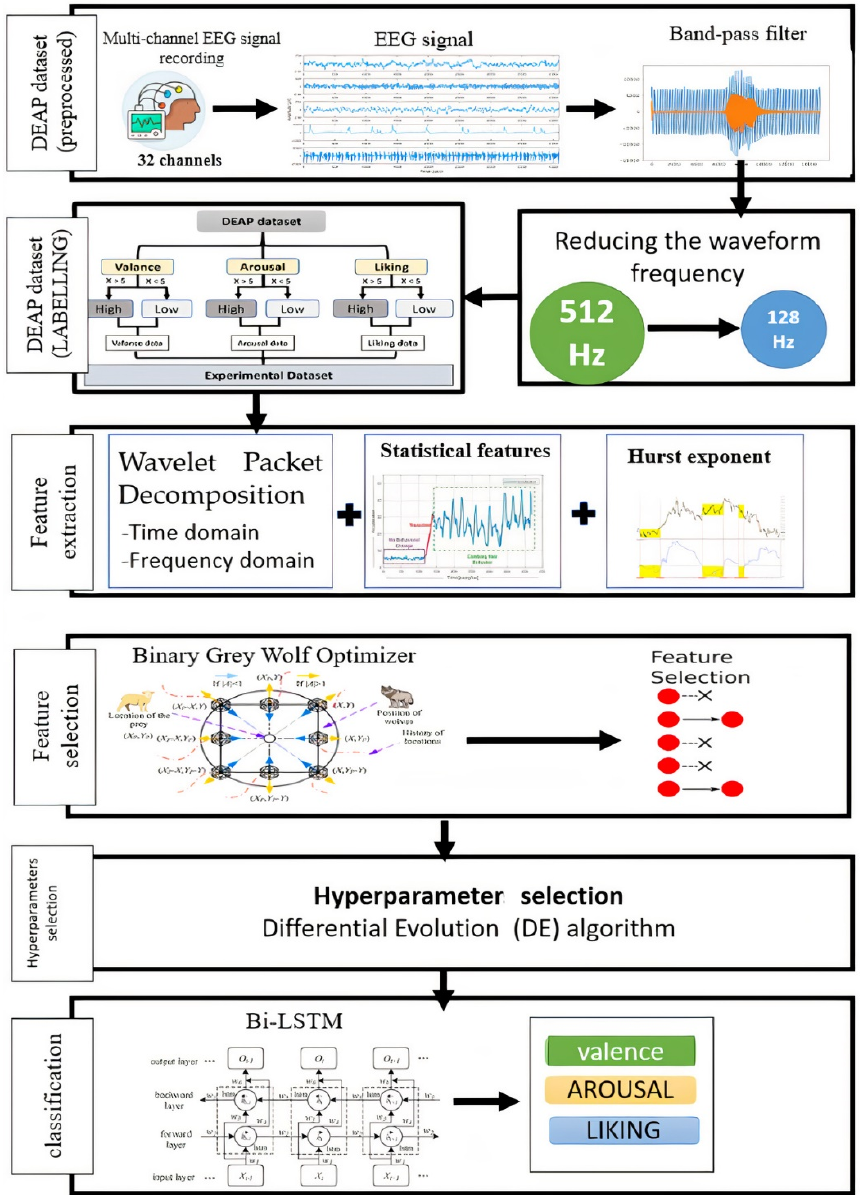
Figure 1. The proposed approach.